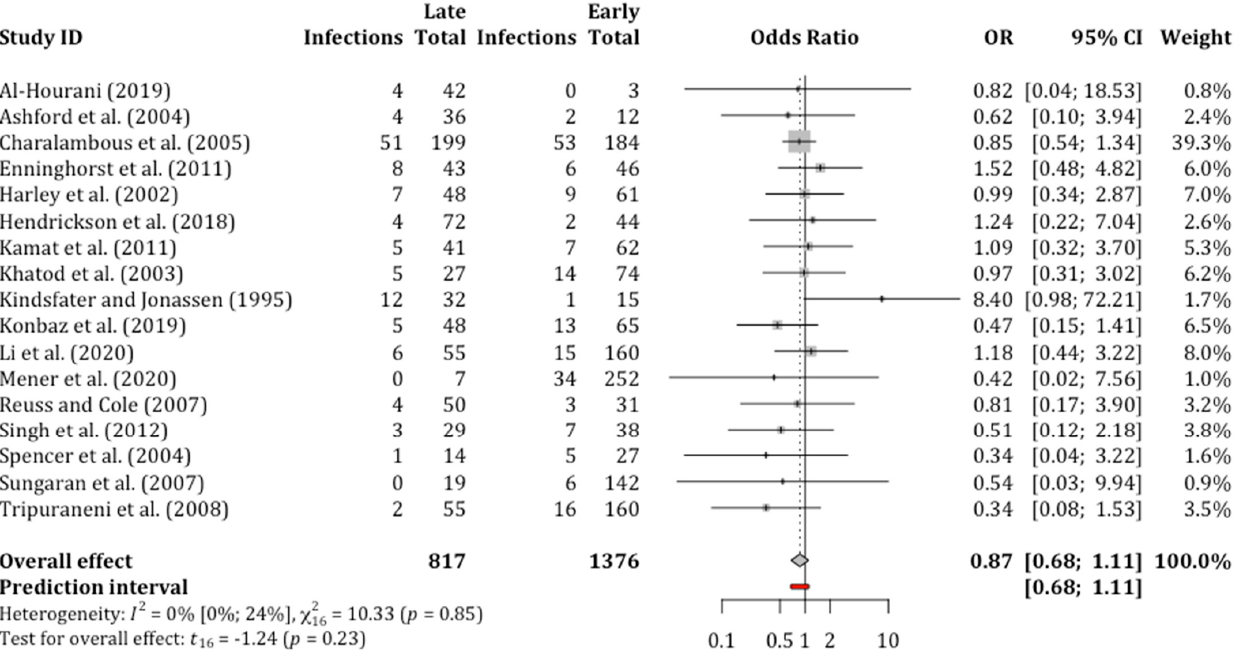
Figure 2. Forest plot of random effects meta-analysis comparing the incidence of developing infection after late surgical debridement compared to early debridement in open tibial fractures. OR = odds ratio; CI = confidence